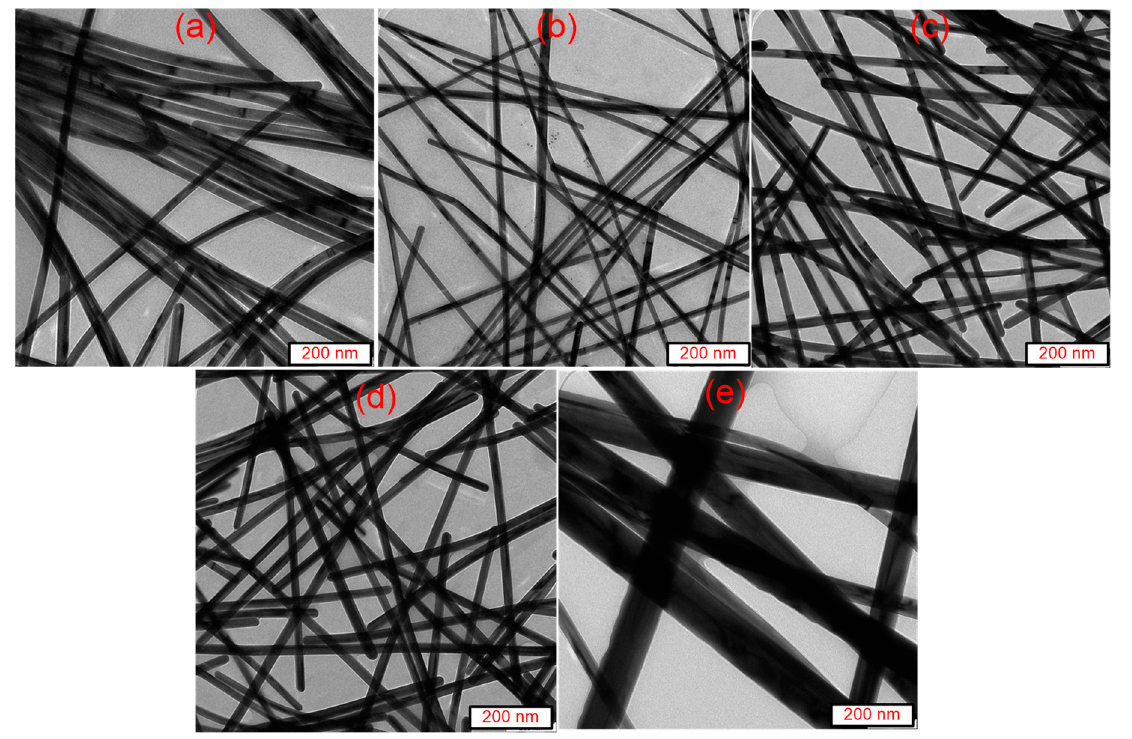
Figure 8. TEM images of AgNWs suspension at the growth time for growth temperature: ( a ) 140, ( b ) 150, ( c ) 160, ( d ) 170, and ( e ) 180 ◦ C.